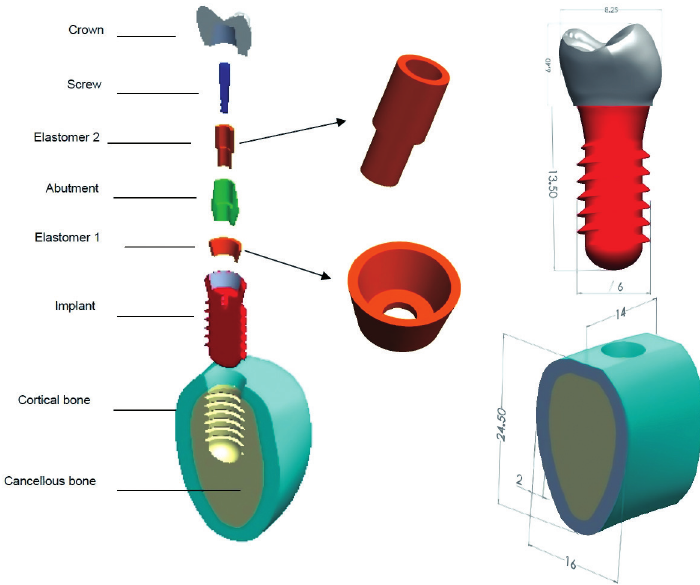
Figure 1- Components of an Osteoplant ® implant model with two incorporated elastomeric stress absorbers with global data